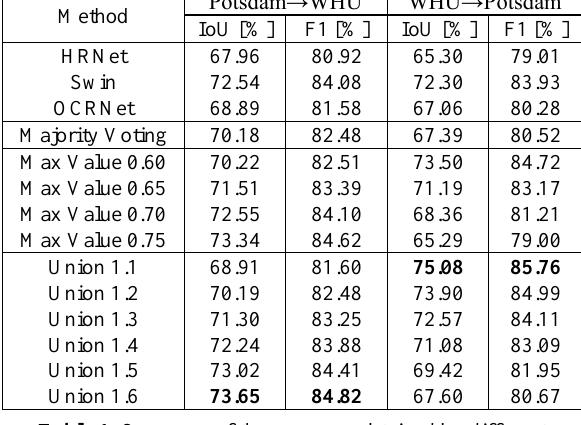
Table 1 . Summary of the accuracy obtained by different